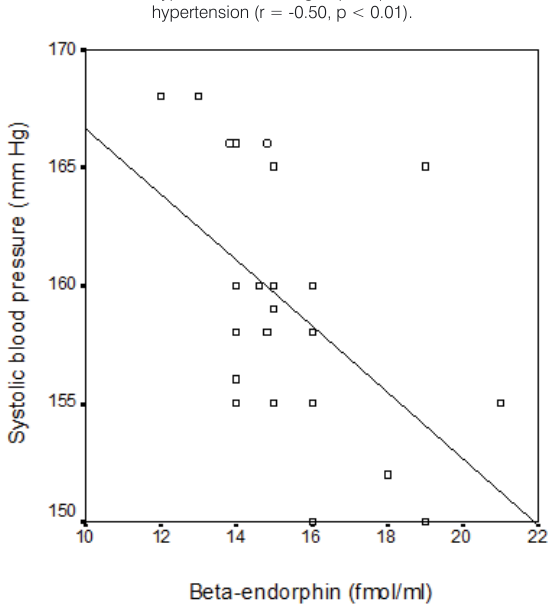
Figure 1. The relation between plasma ß-endorphin levels and systolic blood pressure values in response